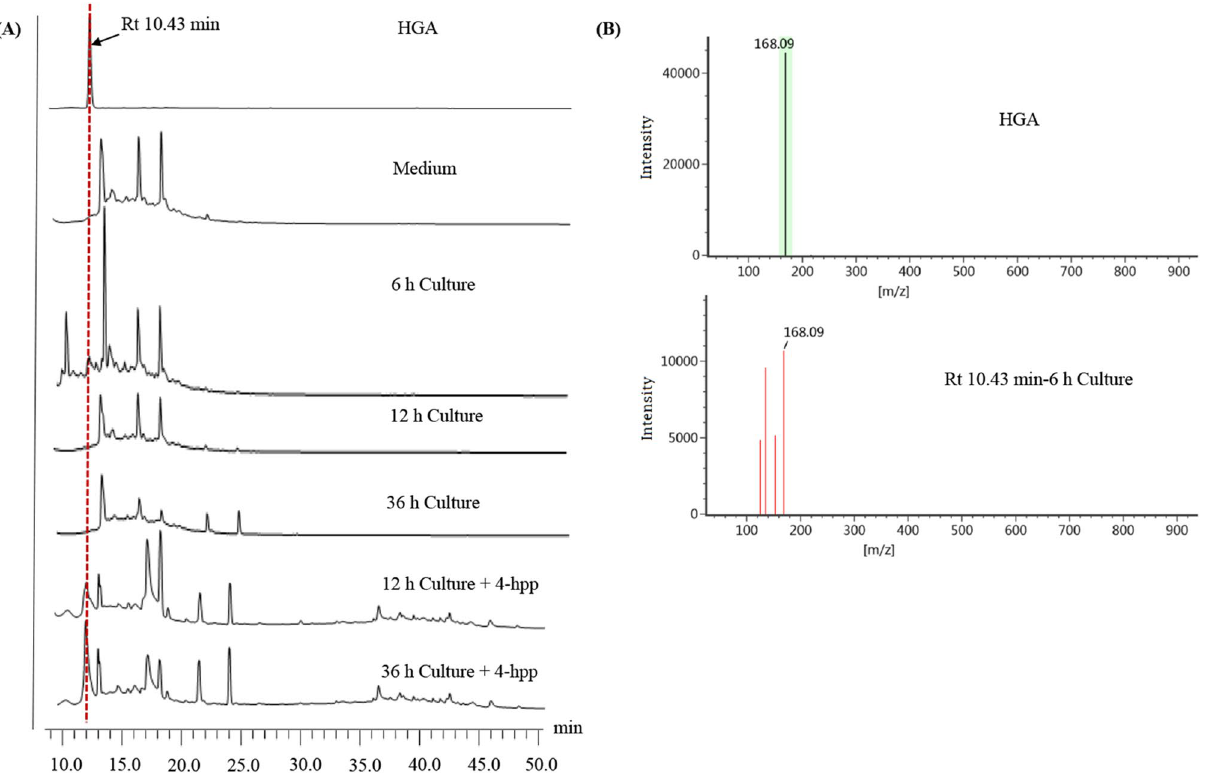
Figure 3. HPLC and MS analysis of HGA. ( A ) HPLC analysis. HGA is used as a standard; Medium is used as a negative control. 6, 12, and 36 h culture represent culture supernatant of strain ZL-24 at 6, 12, and 36 h. 12 h Culture + 4-hpp and 36 h Culture + 4-hpp represent the reaction mixtures of 12 h or 36 culture supernatant and 4-hpp. ( B ) MS analysis. HGA is used as a standard; Rt 10.43 min-6 h Culture represents the peak with Rt 10.43 min in HPLC profile of 6 h culture